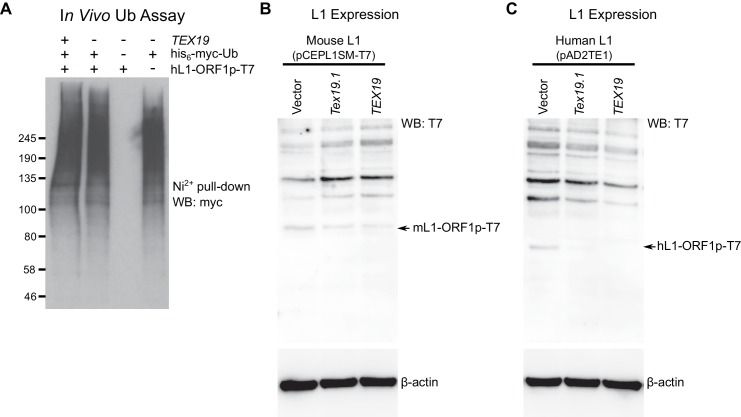
TEX19 orthologs regulate L1-ORF1p abundance.(A) Control for cell-based ubiquitylation assay shown in
Figure 4C. Ni2+
pull-downs were Western blotted (WB) with anti-T7 antibodies to detect
the immunoprecipitated his6-myc-Ub conjugates. MW markers (kD)
are shown beside blots. (B, C) Hamster XR-1 cells were
transiently transfected with a synthetic mouse or human L1 construct
containing T7 epitope-tagged ORF1p (panel B: mouse, pCEPL1SM-T7; panel C,
pAD2TE1, human), and either empty vector, Strep-Tex19.1
or Strep-TEX19 expression constructs. Cells were Western
blotted (WB) for the T7 epitope tag, and for β-actin as a loading control
72 hr post-transfection. Arrows indicate the L1-ORF1p-T7 bands (43 kD for
mL1-ORF1p-T7, 40 kD for hL1-ORF1p-T7). The high molecular weight bands
migrating more slowly than the L1-ORF1p-T7 constructs in panels B and C
likely represent the anti-T7 antibody cross-reacting with cellular
proteins from the host cells.